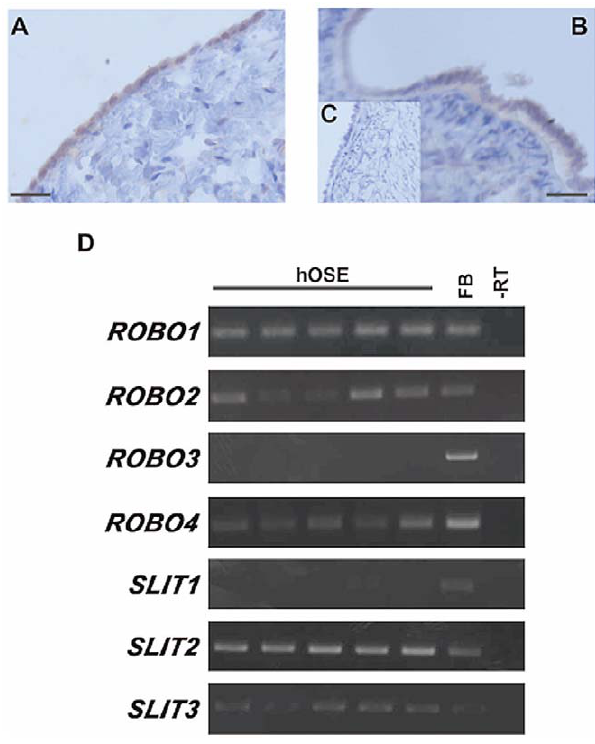
Figure 1. Expression analysis of the SLIT and ROBO gene families in human OSE (hOSE). A ) Light-field microscopy of ovary showing specific staining for SLIT2 (brown) in the OSE. B ) Likewise positive ROBO1 (brown) staining was also observed in the OSE. C ) No staining was observed in negative controls. Scale bars represent 100 m m. D ) RT-PCR for SLITs and ROBOs in cultured hOSE. With the exception of SLIT1 and ROBO3 the members of the SLIT and ROBO families were expressed in hOSE. FB=Fetal Brain positive control; -RT=RT negative negative control.